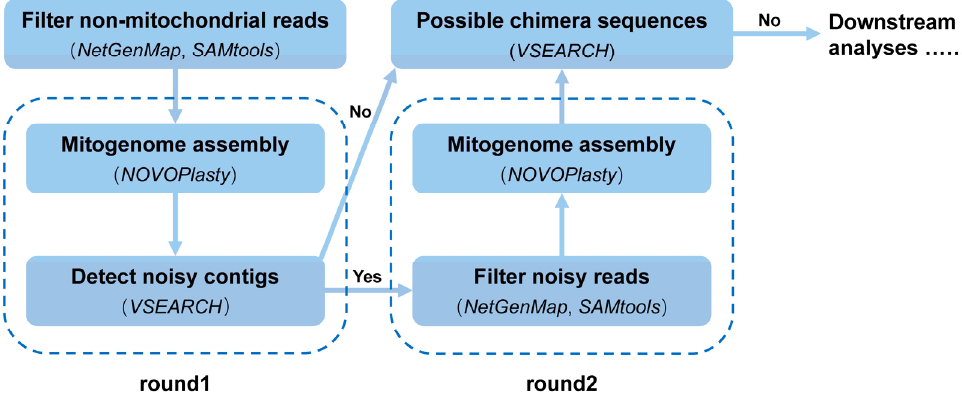
Figure 1. Workflow of the MMG assembly. Bioinformatic tools used in each step are marked as